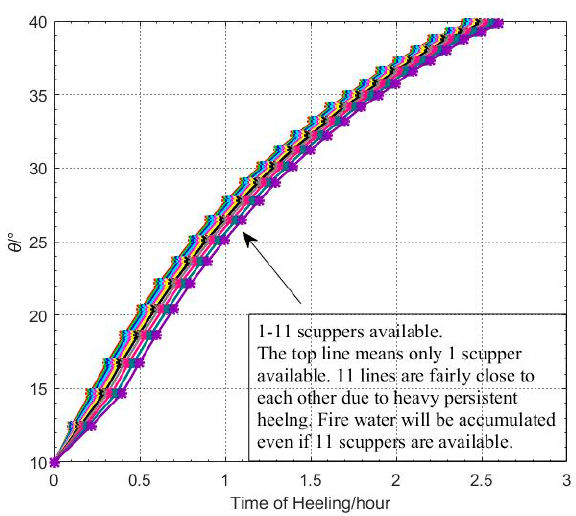
Figure 10. Heeling angle and heeling time θ 0 = 10°.